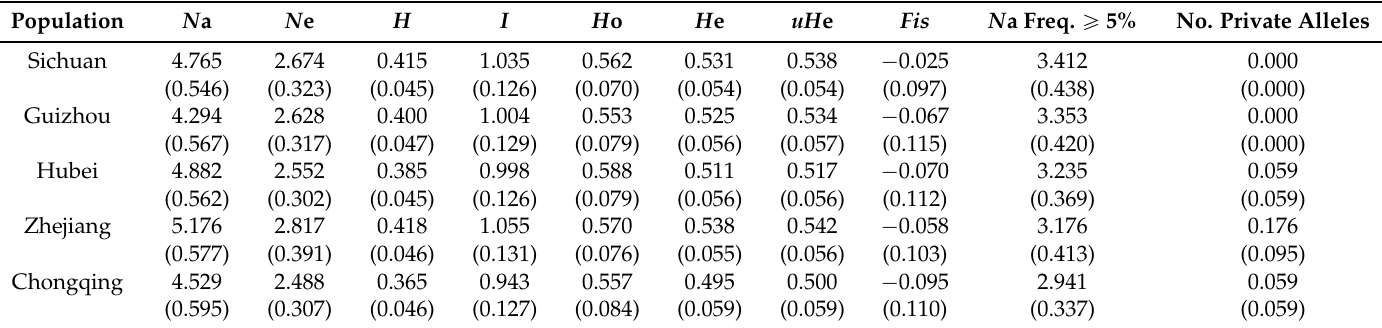
Table 3. Polymorphic information among populations.